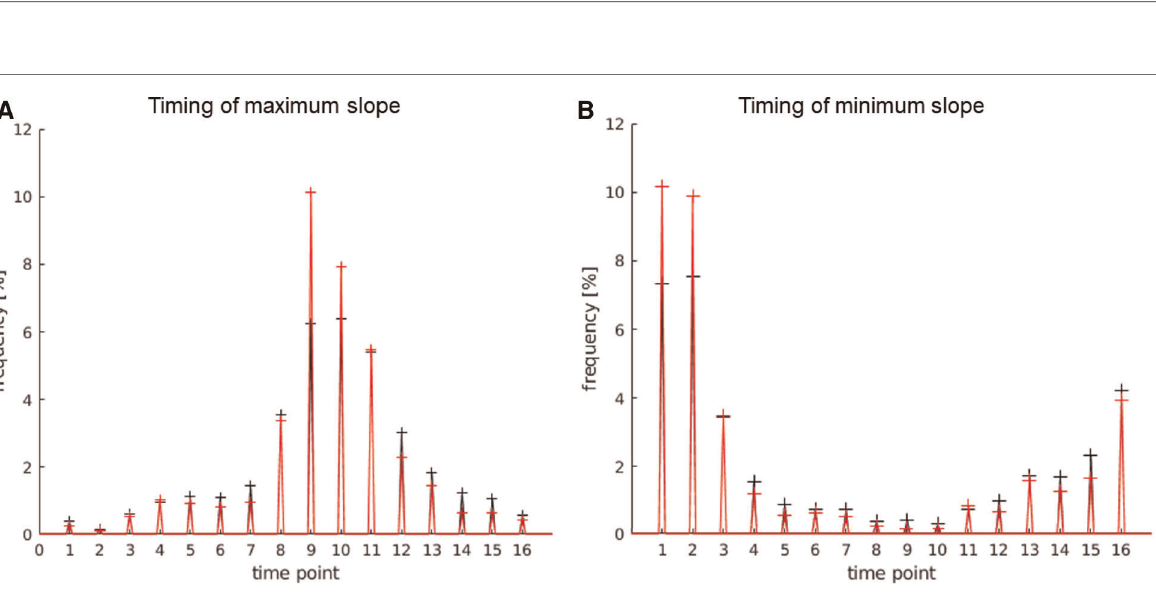
FIGURE 6 Timing of the max. slope ( A ) and min. slope ( B ); 1 timepoint=3 s. The values of the language areas are displayed in red; the values of the total number of activations displayed on the map in black. ( A ) Many activations within the language area have a slope maximum between timepoint 8 and 12, i.e., 24 s and 36 s, with the highest number at time point 9, i.e., second 27, which is 3 s after the start of the activation block. ( B ) Most activations within the language area have the slope minimum between timepoint 16 and 3, i.e., 48 s and 9 s, with the highest number at time point 1, i.e., 3 s after the beginning of the rest block and after the end of the activation